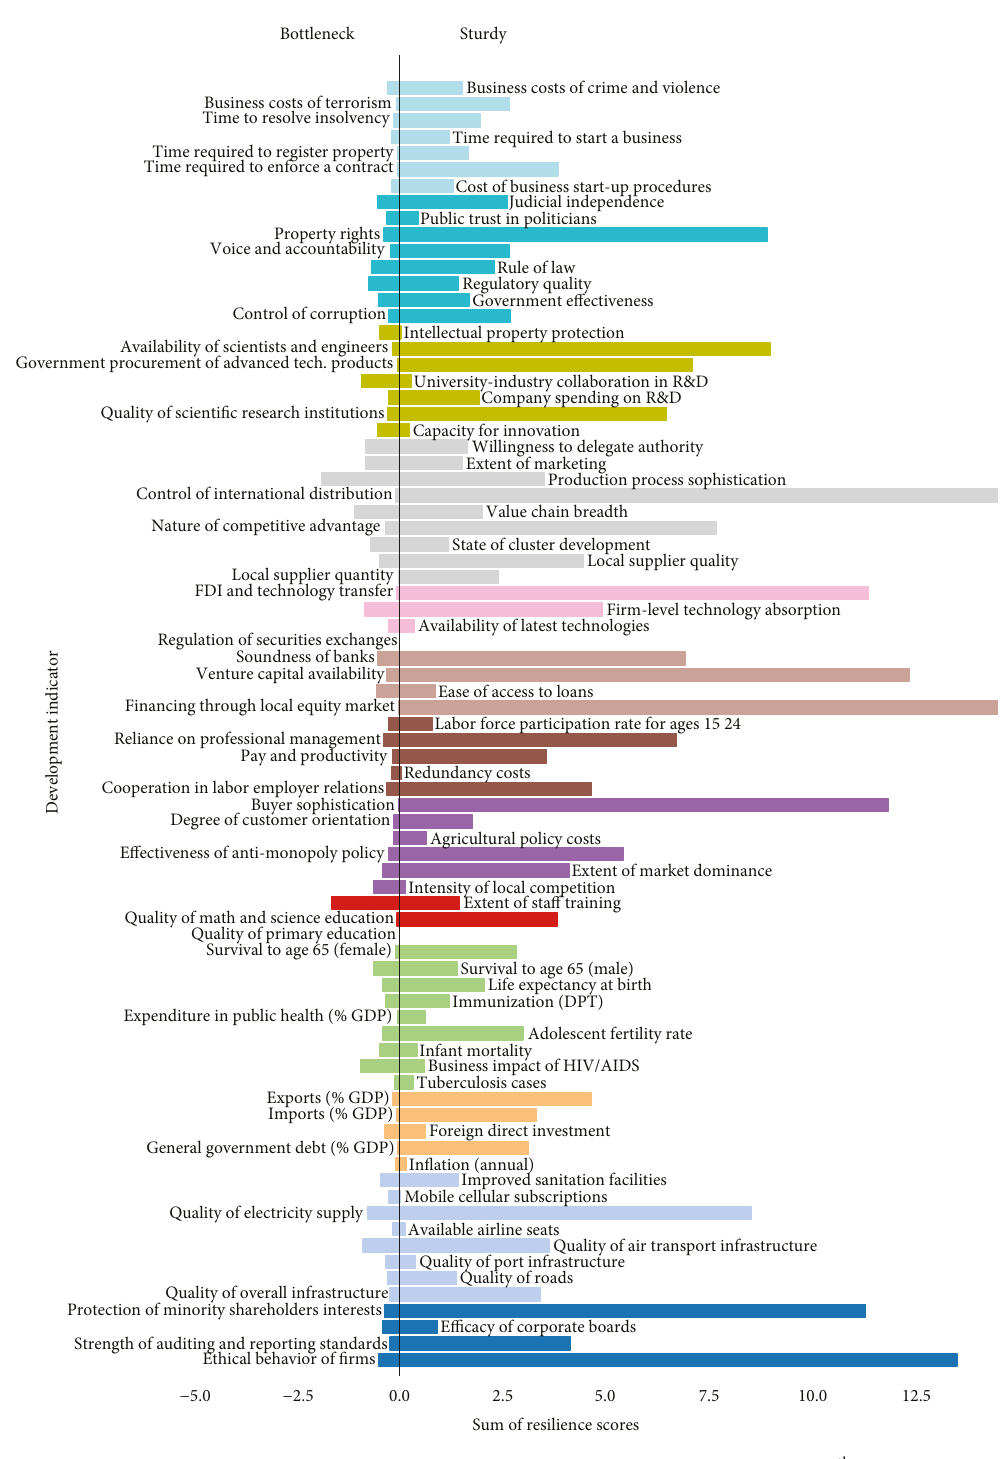
Figure 12: Sturdy policies and bottlenecks by development indicators. Bottlenecks: fragile policies in the 5 th percentile of relative priorities. Sturdy: resilient policies in the 95 th percentile of relative